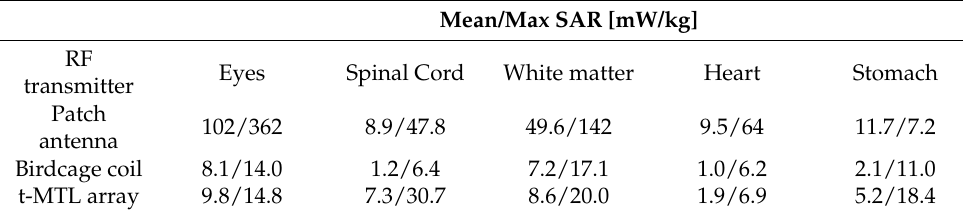
Figure 10. The computed |B 1+ |-field and SAR maps in axial views, for ( a ) the brain, ( b ) torso, and heart, as well as ( c ) the histogram of the SAR distribution per volume m 3 in the whole hu- man model. Table 2. Mean and maximum